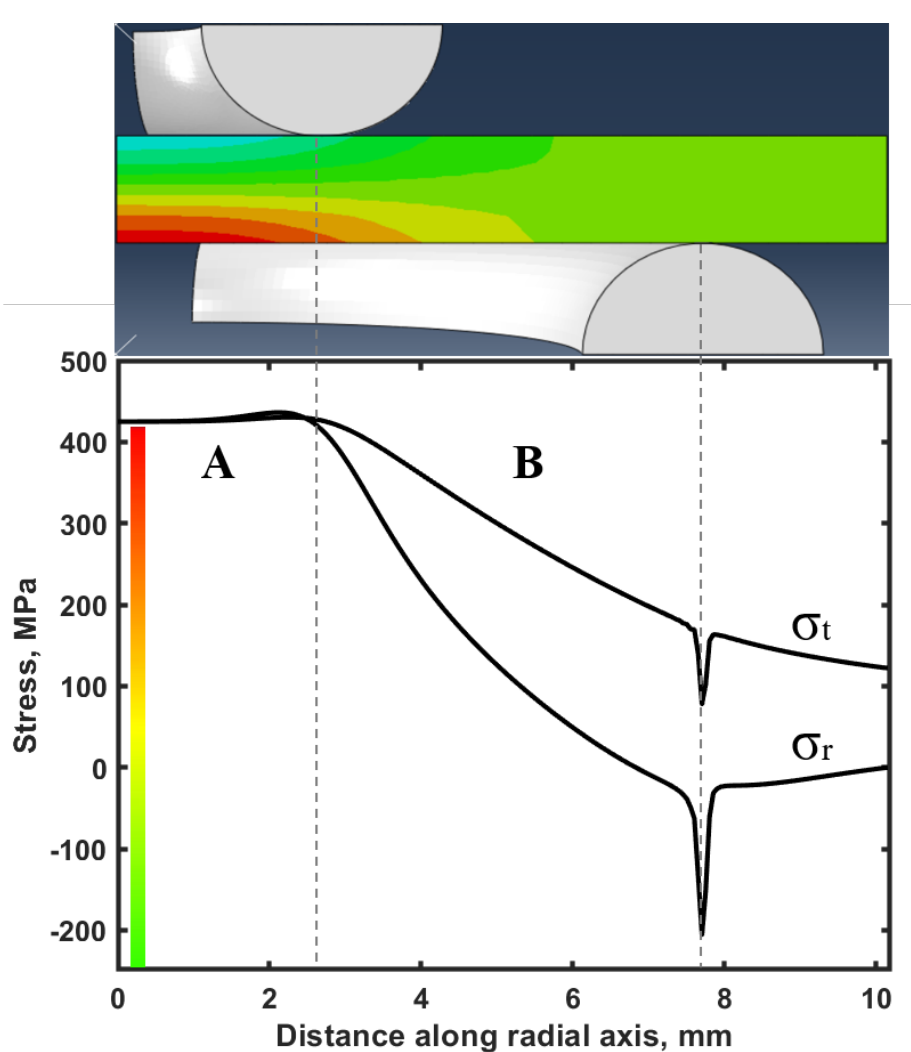
Figure 11. The stress distribution in a B 4 C disk upon biaxial loading. σ r is the stress distribution in the radial direction and σ t is the stress distribution in the tangential direction.